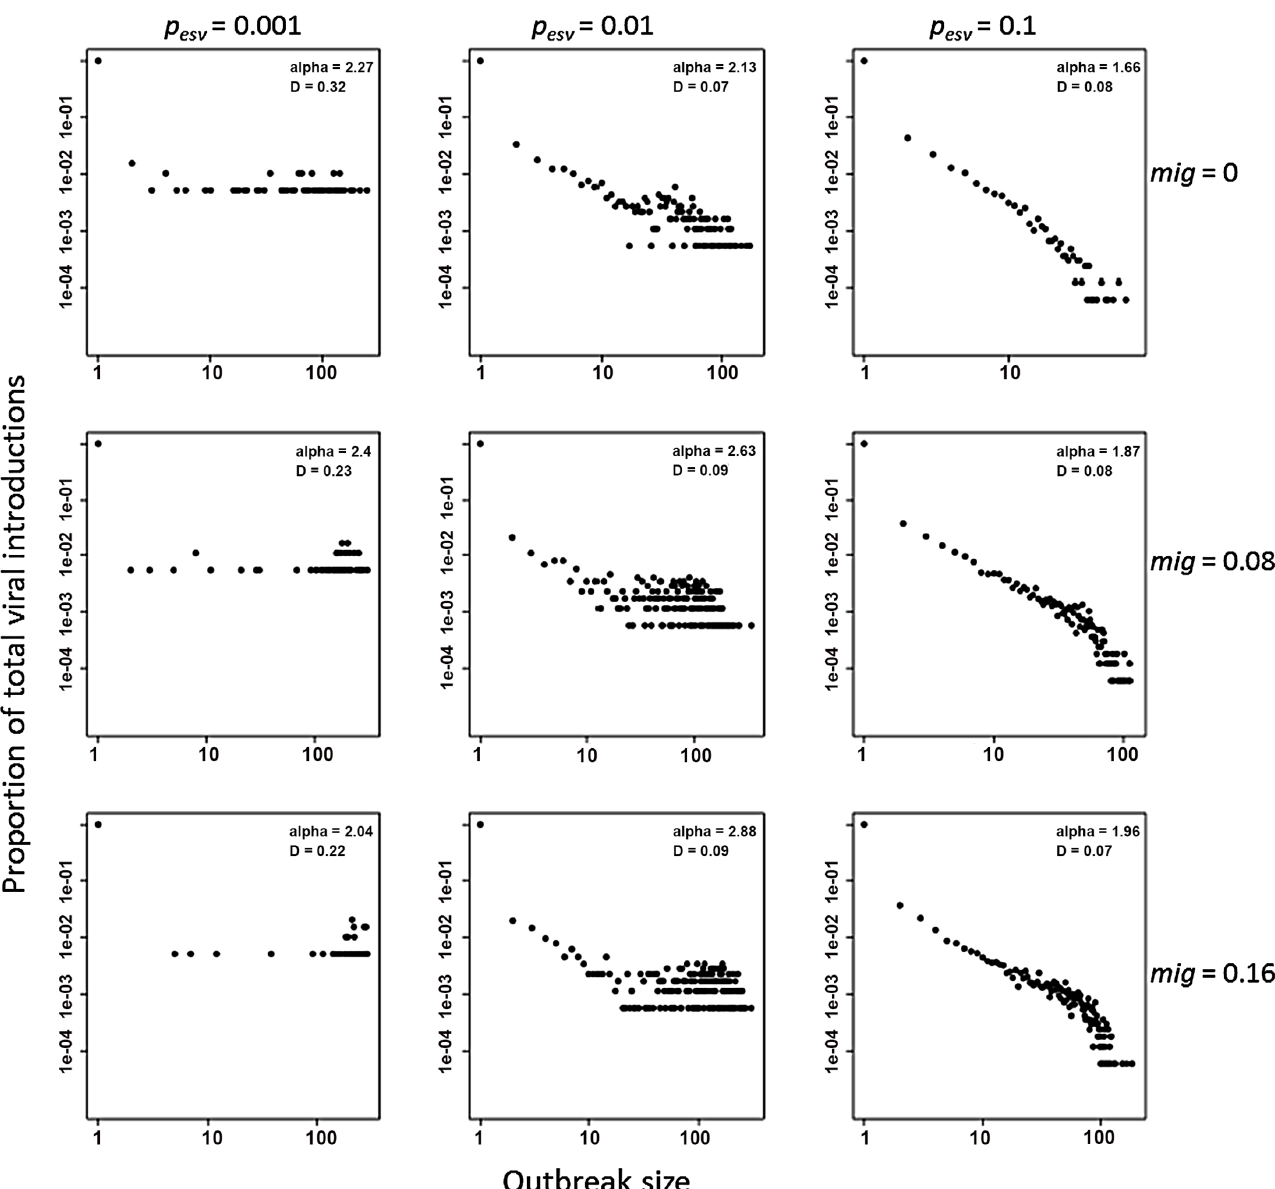
Fig 3. Simulated outbreak size distributions for each combination of p esv and mig as shown in Fig 1. Each point represents an independent viral introduction into the 2-block patch in years 11 – 20, tabulated across 250 simulations for each parameter combination. Power law fits are shown in red. Lower D values indicate a better fit of the power law to the data. Alpha refers to the power law exponent ( a ). Vector recruitment is parameterized from the patch with the highest frequency of containers > 100 A . aegypti